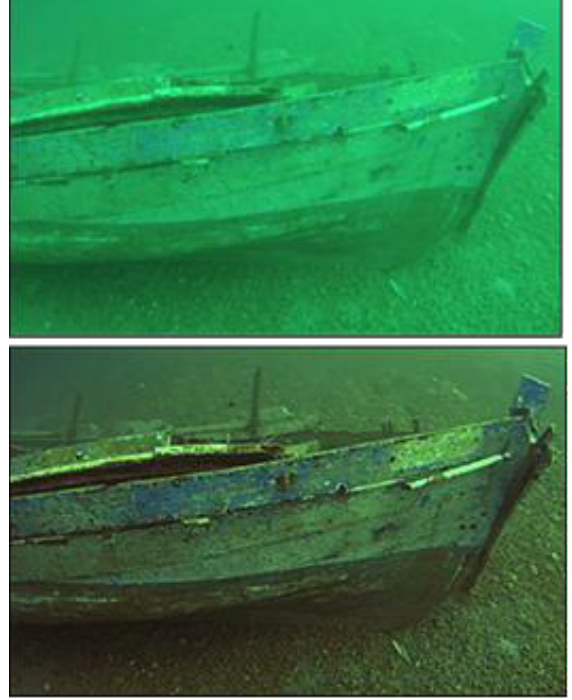
Figure 11. Before (above) and after (below) the application of the radiometric processing of the selected technique